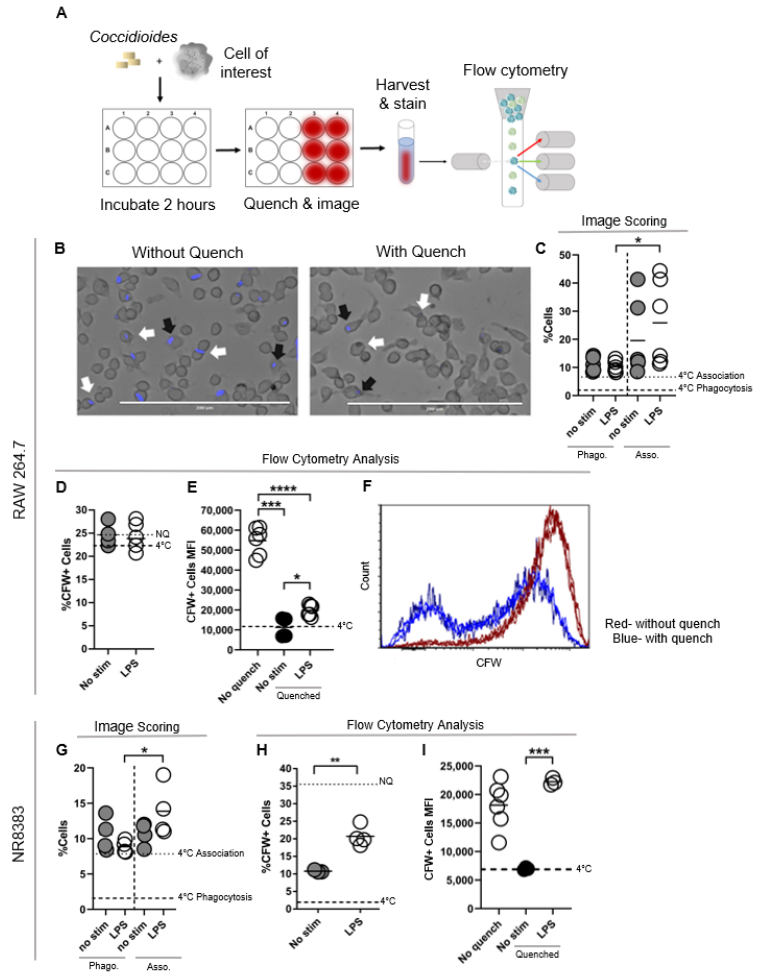
Figure 1. Macrophages poorly phagocytose Coccidioides , although mouse macrophages have a stronger association with Coccidioides . Phagocytosis analysis via flow cytometry complements traditional imaging assay while increasing output efficiency and allowing analysis of association versus phagocytosis. ( A ) 5 × 10 5 cells were incubated 1:1 with CFW labeled Coccidioides for 2 h then left unquenched or quenched using Congo red dye. Cells were imaged then harvested and processed for flow cytometric analysis. ( B – F ) Data from RAW 264.7 mouse macrophages. ( G – I ) Data from NR8383 rat alveolar macrophages. ( B ) Bright field image of CFW- Coccidioides infected RAW 264.7 cells. Externally bound Coccidioides is quenched by Congo red, leaving only the internalized Coccidioides visually discernable by the Pacific blue marker for imaging by fluorescence labeling. White arrows indicate internalized (phagocytosed) Coccidioides, and black arrows show externally bound or externally associated Coccidioides in un-quenched and quenched conditions. ( C – I ) Non- quenched controls = cells harvested but un-quenched, No stim = Coccidioides only conditions without additional stimulation, LPS = pro-inflammatory stimulant, 4 ◦ C = negative phagocytosis control. ( D , H ) Frequency of CFW+ cells gated from Singlet/Live cells. ( E , I ) Mean fluorescence intensity (MFI) of the cells from CFW+ population. ( F ) Representative histogram of CFW fluorescence in RAW 264.7 macrophages incubated with CFW-labeled Coccidioides at 37 ◦ C under quenched conditions (blue line) indicating Coccidioides , or non-quenched (red line) indicating Coccidioides association and engulfment. ( C , G ) Image scoring data. Left side: frequency of cells with internalized Coccidioides ; right side: frequency of cells associating with Coccidioides externally. n = 3–8, data are representative from 2–3 experiments. For all plots, line indicates mean, and each dot is one experimental replicate. Data was analyzed using an unpaired Student’s t -test and outliers excluded using Grubbs Outlier exclusion analysis. * p < 0.05, ** p < 0.005, *** p < 0.0005, **** p <